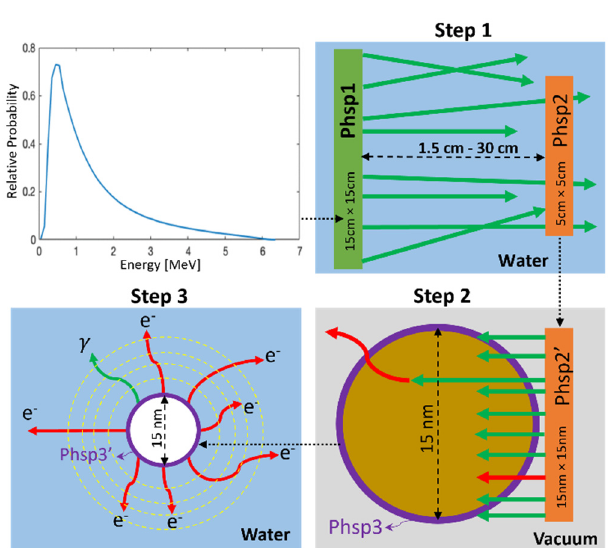
Figure 2. Modular three step multi-scale Monte Carlo (MC) simulated geometry used to determine Gold nanoparticle (AuNP) mediated dose enhancement ratio (DER). Note: red tracks = electrons, and green tracks = photons.